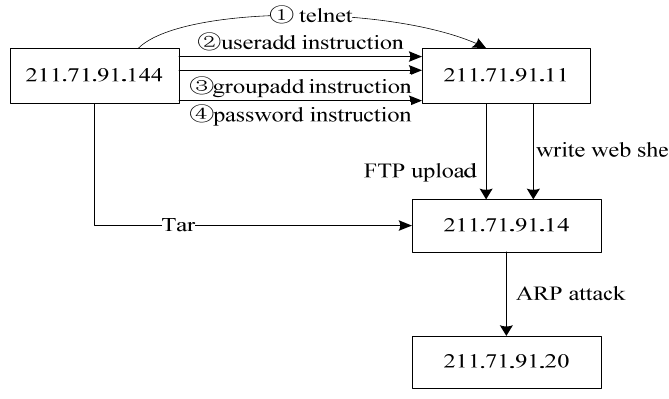
Figure 5. The Evidence Graph of First Experiment Scenario.